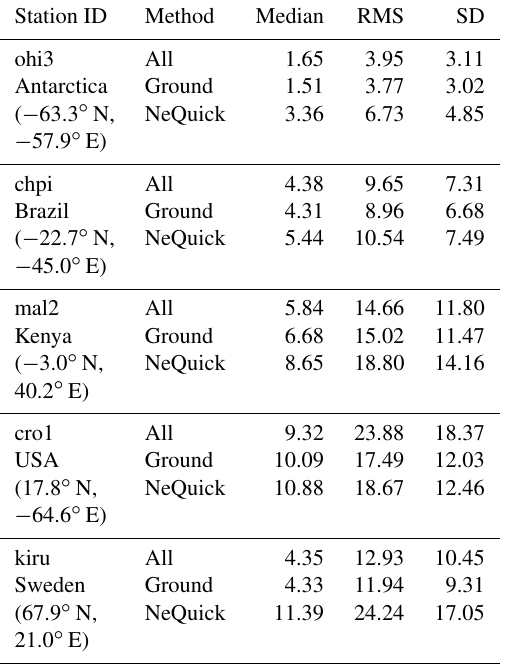
Table 5. The statistics of the absolute sTEC residuals in TECU for DOYs